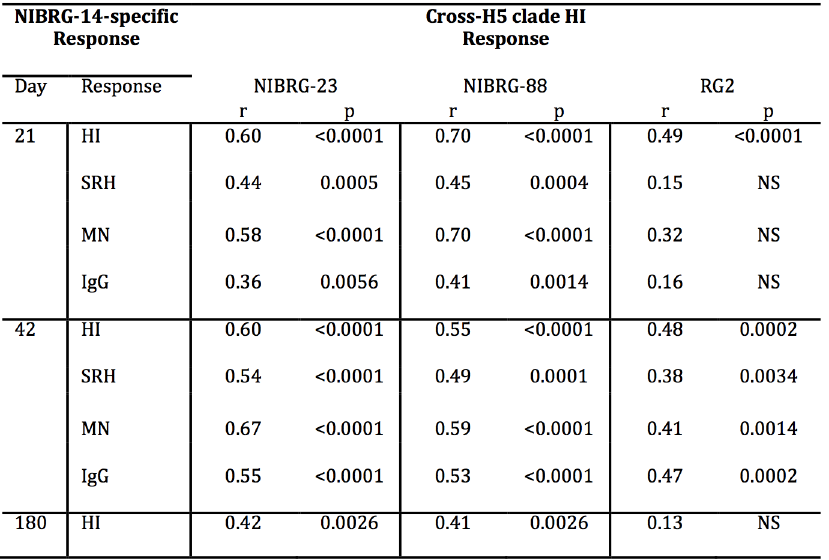
Fig 7. Correlation between serological responses to the homologous and cross-reactive H5N1 strains at days 21, 42 and 180 after vaccination. The correlation between A/Vietnam/1194/2004 (NIBRG-14)- specific HI, SRH, MN and IgG responses and the HI responses against A/turkey/Turkey/1/2005 (NIBRG-23), A/Cambodia/R0405050/2007 (NIBRG-88) and A/Indonesia/5/2005 (RG2) at 21, 42 and 180 days after vaccination. Volunteers were divided into four vaccine groups and were vaccinated with two doses (21 ± 1 days apart) of inactivated virosomal H5N1 vaccine alone (30 μ g HA) or 1.5, 7.5 or 30 μ g HA adjuvanted with Matrix-M (50 μ g). Data from the four vaccine groups were combined to calculate the Spearman rank correlation coefficient (r) value (adjusted for multiple comparisons) for each association between the homologous and cross-H5 clade serological response. Abbreviations: p, Two-tailed p value (95% confidence interval); NS, no significant correlation.